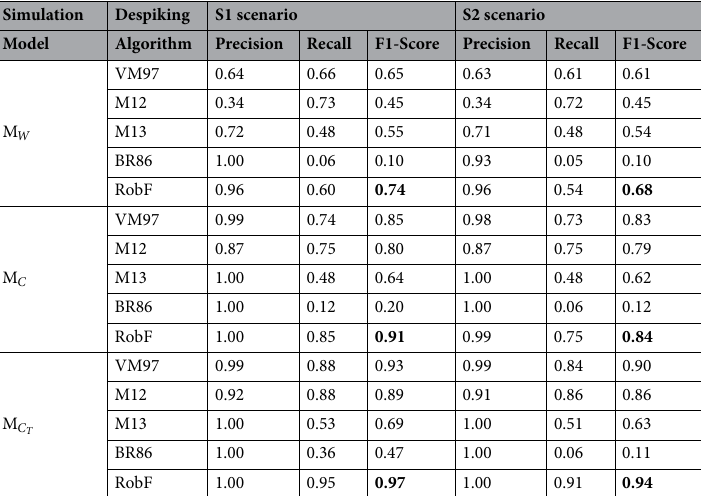
Figure 5. Illustrative examples of simulated time series of vertical wind speed ( w , m s − and non-stationary ( c ) carbon dioxide concentration (CO 2 , µ mol mol − corrupted with spike events (red dots) according to S1 and S2 scenarios, respectively.